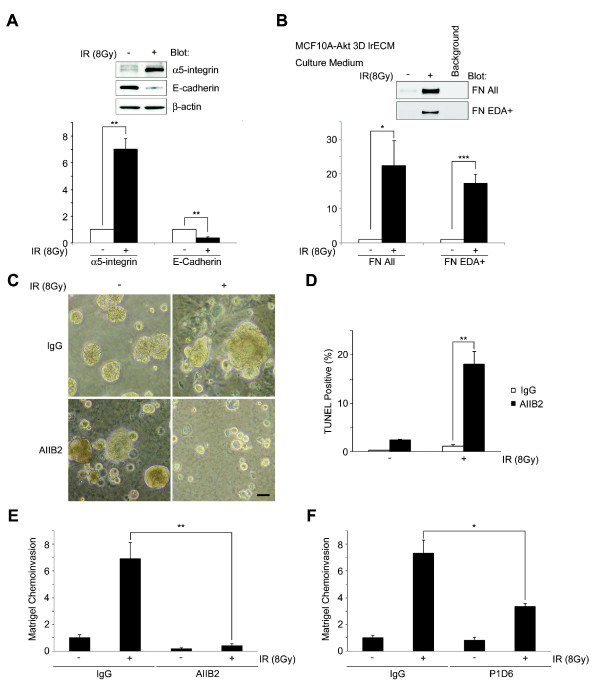
β1-integrin signaling is targeted to suppress invasive recurrence post-IR in MCF10A-Akt cells in three-dimensional lrECM. (A) On Day 30 cultures, up-regulated α5β1-integrin and down-regulated E-cadherin expression observed on the post-IR cultures. Columns, mean intensity (n = 3; **, P < 0.01). (B) Up-regulation of FN and EDA+FN was observed in culture medium of cells post-IR. Columns, mean intensity (n = 5; *, P < 0.05; ***, P < 0.001). (C) Phase-contrast images. IR-induced invasive phenotype was abrogated by AIIB2 compared to IgG. The antibodies were added from day 0 of the second three-dimensional cultures. Bar = 50 μm. (D) Apoptosis was measured by TUNEL-positive cells in AIIB2-treated cultures -/+ IR (mean = 18.1% ± 3.9, P < 0.01). (E-F) Matrigel chemoinvasion was significantly increased in the surviving cells post-IR, and inhibited by β1-integrin (AIIB2, five-fold, P < 0.01) or α5-integrin (P1D6, two-fold, P < 0.05) inhibitory antibodies. DCIS, ductal carcinoma in situ; FN, fibronectin; IgG, immunoglobulin G; IR, ionizing radiation; lrECM, laminin-rich extracellular matrix; TUNEL, terminal deoxynucleotidyl transferase-mediated dUTP nick end labeling.